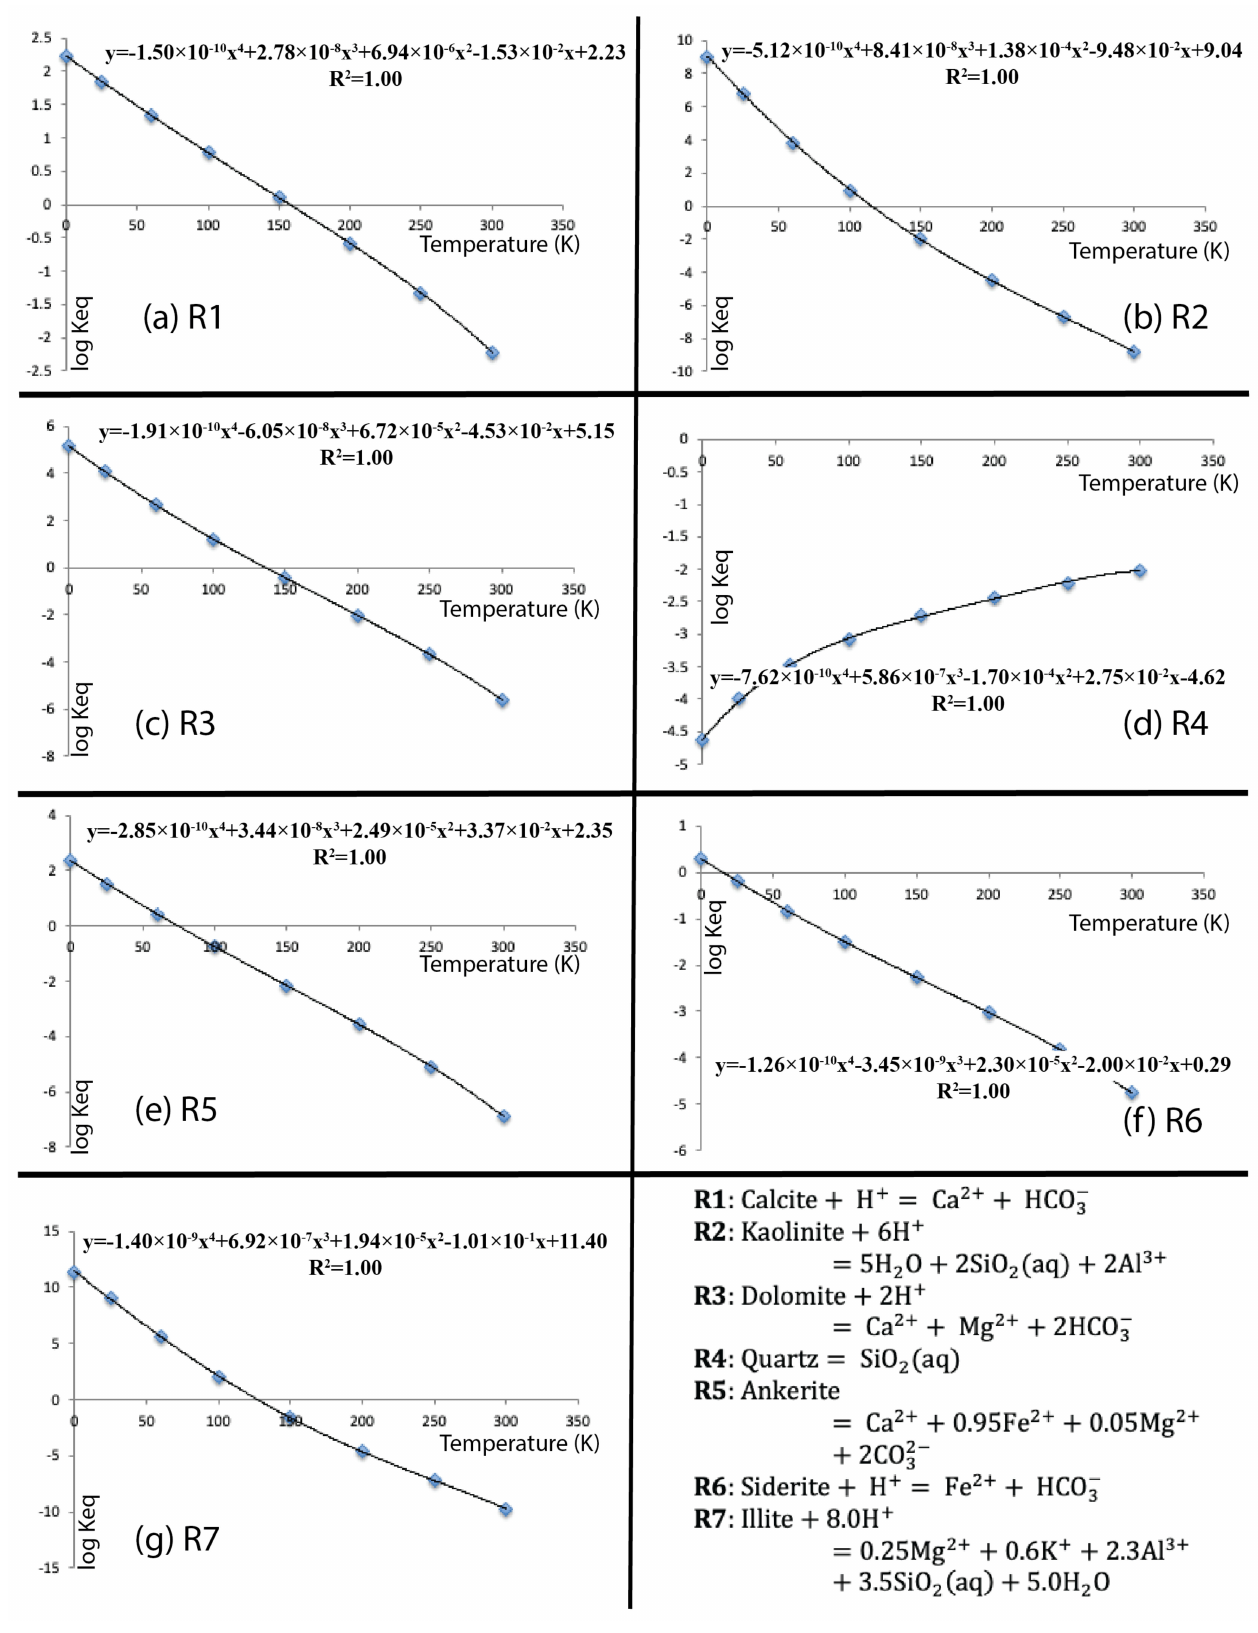
Figure A1. Relationship between chemical equilibrium constants and temperature based on the EQ3/6 database (blue diamonds) for determining the chemical equilibrium constants of seven mineral reactions